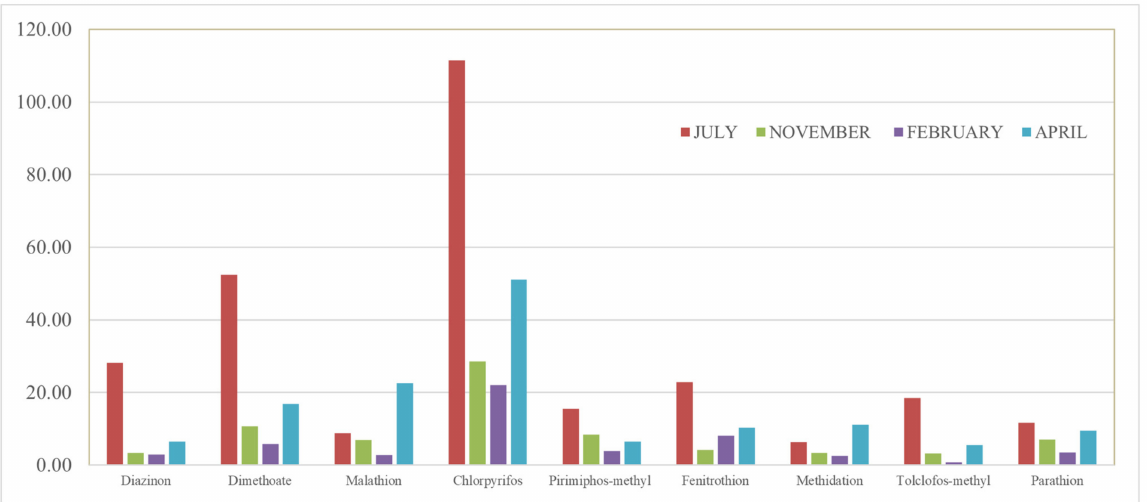
Figure 5. Total OPP concentrations detected in water (sum of WDP and SPM-ng L − 1 ) during the four sampling seasons (July, November, February, and April) at 10 sampling